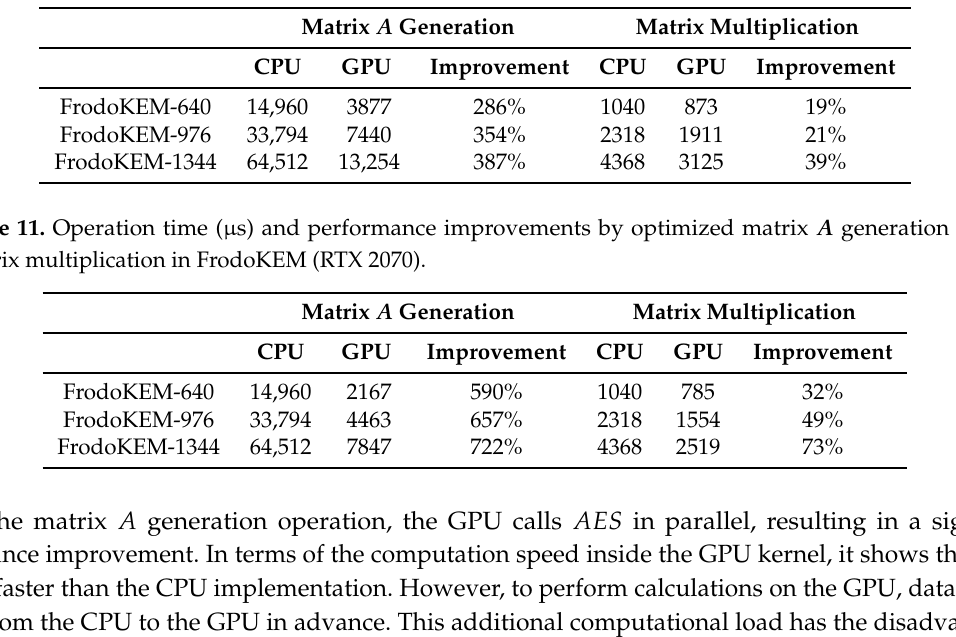
Table 10. Operation time ( µ s) and performance improvements by optimized matrix A generation and matrix multiplication in FrodoKEM (GTX 1070).